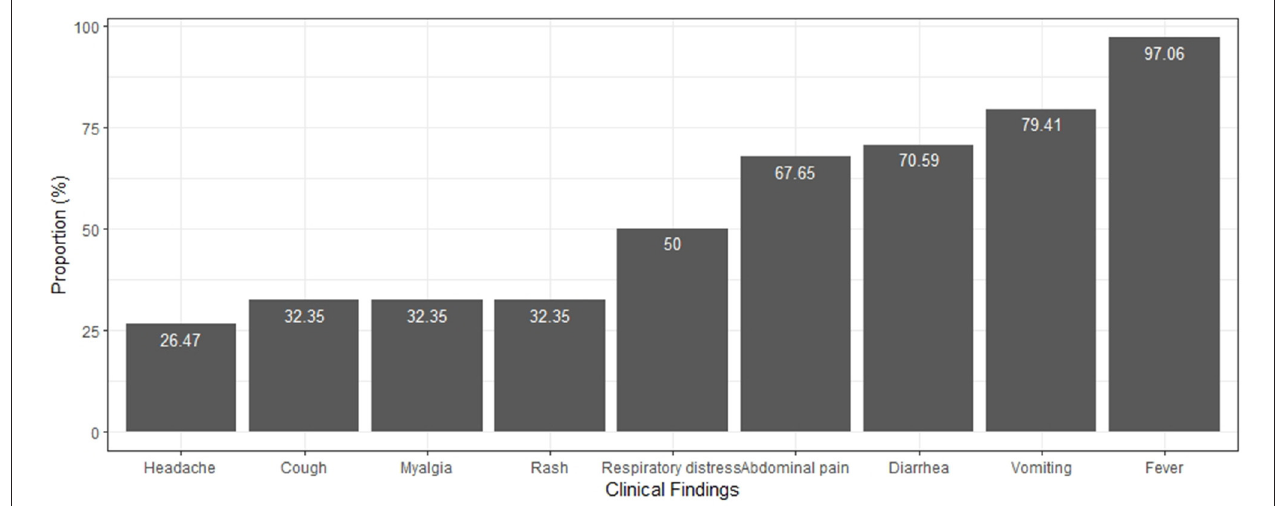
FIGURE 1 | Clinical findings in patients with MIS-C.